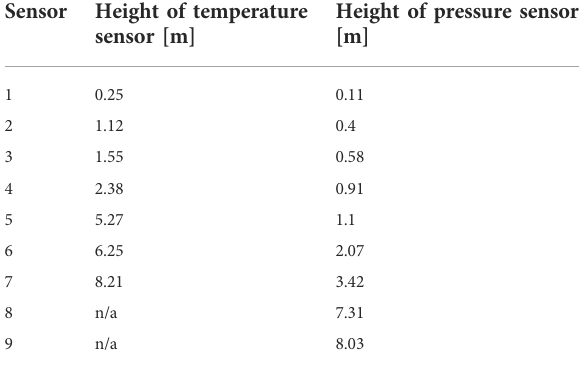
TABLE 6 Heights of the temperature and pressure sensors of the experiment (starting from the bottom of the reactor). Sensor Height of temperature sensor